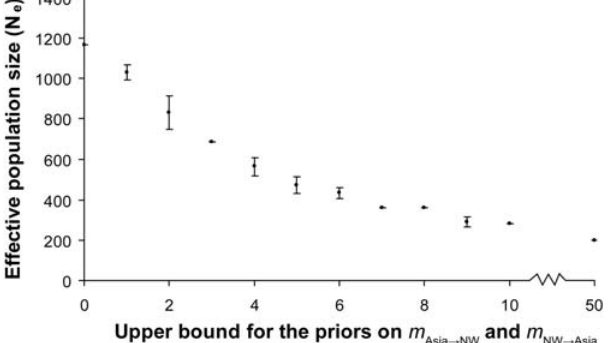
Figure 3. Graph of IM results for the combined nuclear and mitochondrial coding DNA dataset. The plot depicts mean N e for the Amerind founder population (y-axis) as a product of increasing the constraint on the upper bound of the priors for the migration rates (x- axis). In these analyses, the prior on the lower bound of the divergence time was uniformly set to 15 kya on the basis of known archaeological materials for human occupation in the New World (see text). Each point is based on the average of the estimated medians for ten independent replicate analyses, with the bars corresponding to 6 1 standard deviation. These standard deviations are often small (with coefficients of variation less than 0.01), since their Markov chains were run for 100 million generations